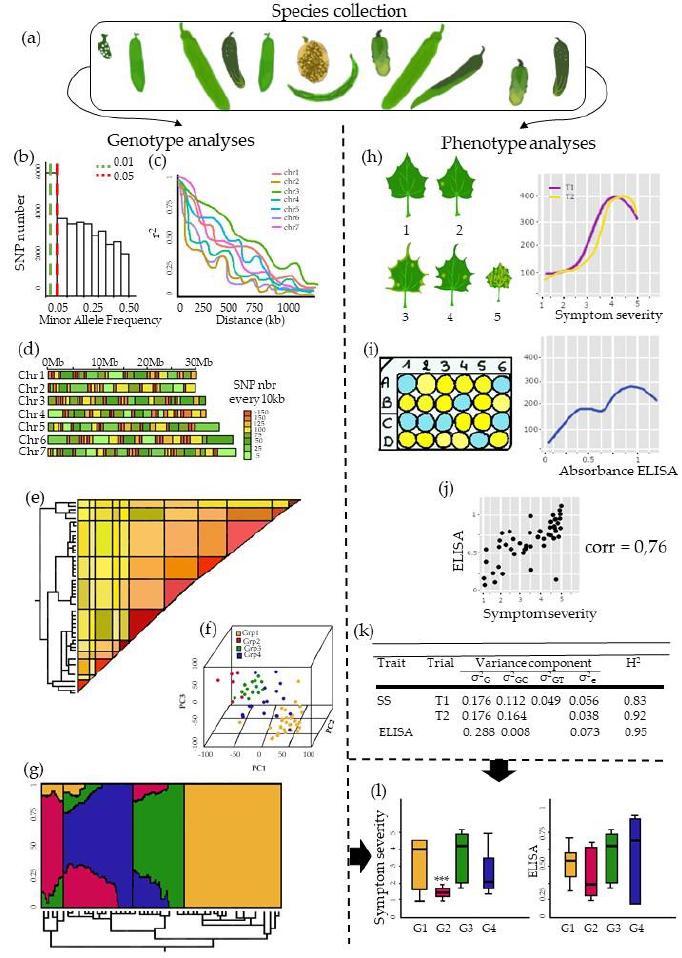
Figure 3. Overview of the main figures of a fictitious pre-GWAS pipeline. ( a ) A collection of genotypes is genotyped and phenotyped. ( b ) Histogram of minor allele frequency distribution with thresholds 0.01 (green) and 0.05 (red). ( c ) Genome-wide linkage disequilibrium decay for the seven chromosomes. ( d ) The density of SNPs on the seven chromosomes within 10 kb window. ( e ) A heatmap of the kinship matrix suggested high level of relatedness among some genotypes. ( f ) Principal component analysis indicates the structuration of the population in at least three groups. ( g ) Population structure; four subpopulations were identified, red, blue, green. and yellow. ( h ) Genotypes are phenotyped regarding a symptom severity (SS) scale ranging from 1 (no symptom) to 5 (leaf deformation and severe yellowing) two consecutive years (T1 and T2); the SS distribution displays an excess of susceptible genotypes. ( i ) The viral load is approximated for T1 via ELISA absorbance, the absorbance distribution follows a bimodal distribution, and highly resistant genotypes are rare. ( j ) The correlation between SS and ELISA absorbance phenotypes is high. ( k ) Heritabilities for SS for T1 and T2 and ELISA absorbance are great. ( l ) SS T1 and ELISA absorbance of the four genetic subgroups; the second genetic subgroup is significantly more resistant for SS T1.